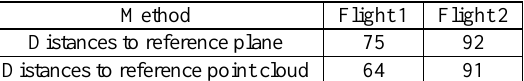
Table 4. LiDAR UAS point cloud absolute accuracy (RMSE [mm]) evaluated with 2 different methods.